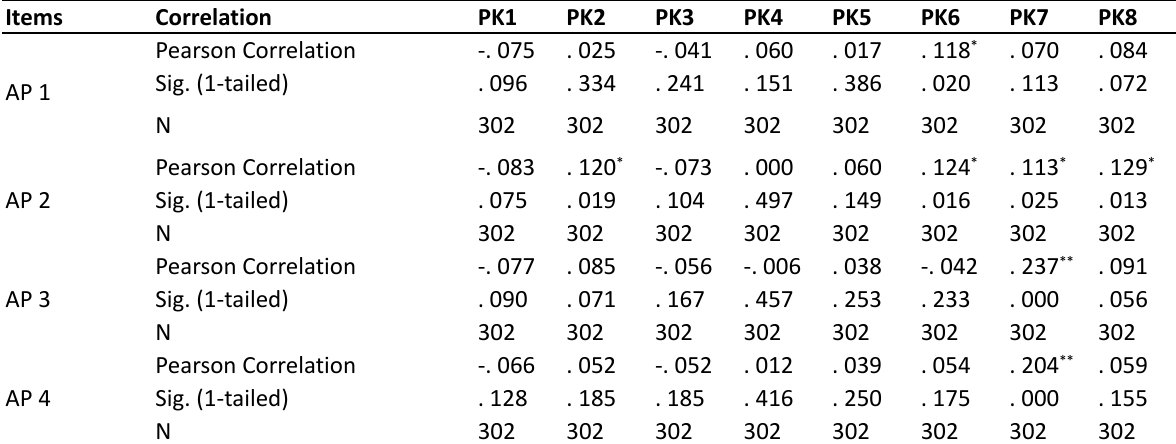
Table 5. Correlations between the CT practical knowledge and the PE-ST attractiveness